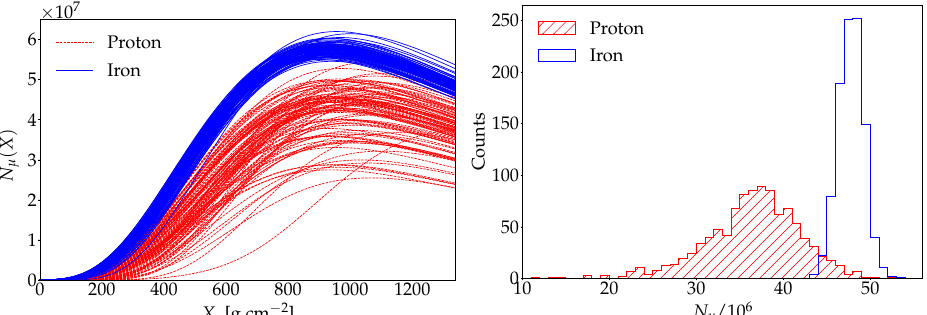
Figure 3. Left : Number of muons as a function of the atmospheric depth for proton- and iron- initiated air showers. Right : Distributions of the total number of muons at ground for proton- and iron-initiated air showers. The primary energy is E = 10 19 eV and the zenith angle is θ = 40 ◦ . The observation level is located at sea level and the threshold energy of the muons is 1 GeV. The simulations are performed with EPOS-LHC.